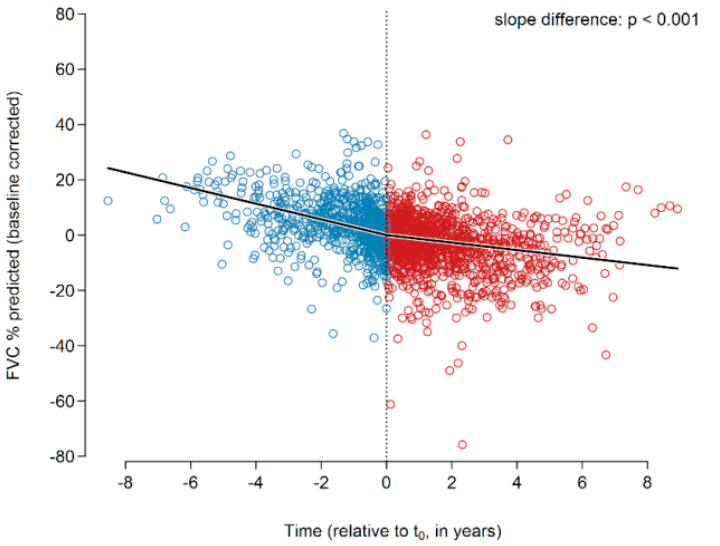
Figure 1. Changes in the FVC slope of the entire IPF cohort prior to (all blue circles) and after (all red circles) initiation of pirfenidone treatment. A significant change of the slope was encountered ( p < 0.001). Abbreviations: FVC—forced vital capacity.